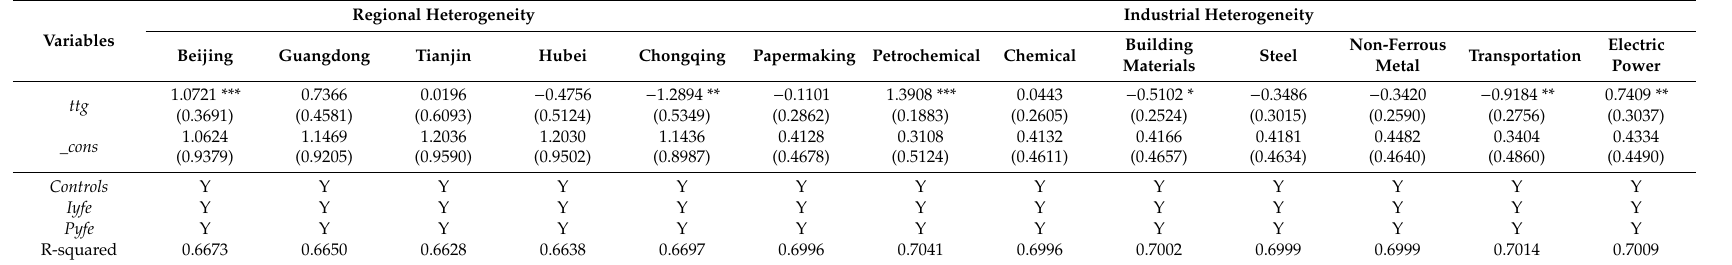
Table 4. Heterogeneity analysis